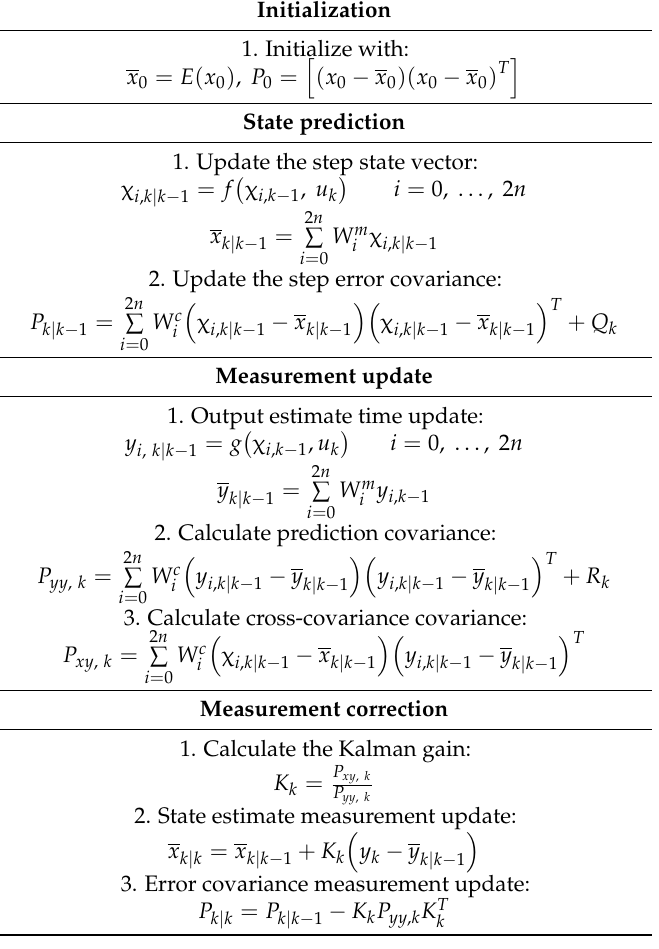
Table 3. Summary of the unscented Kalman filter (UKF) approach for SOC